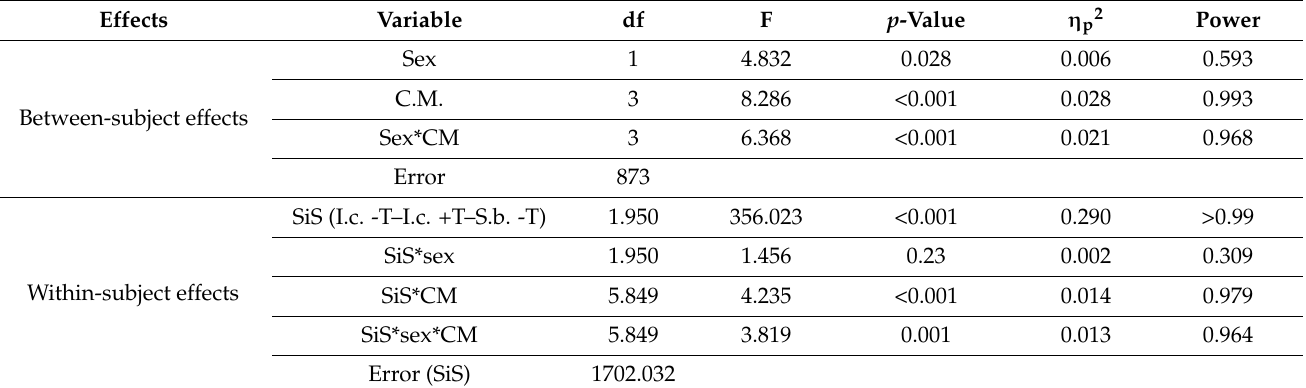
Table 2. ANOVA for correct mask